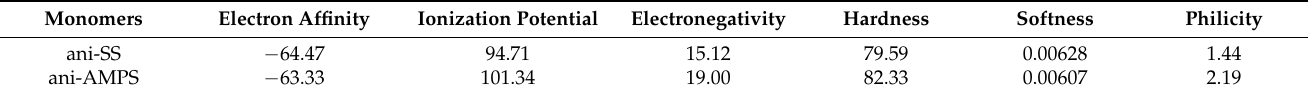
Table 1. Global descriptors of the ani-SS and ani-AMPS monomers, kcal/mol. Monomers Electron